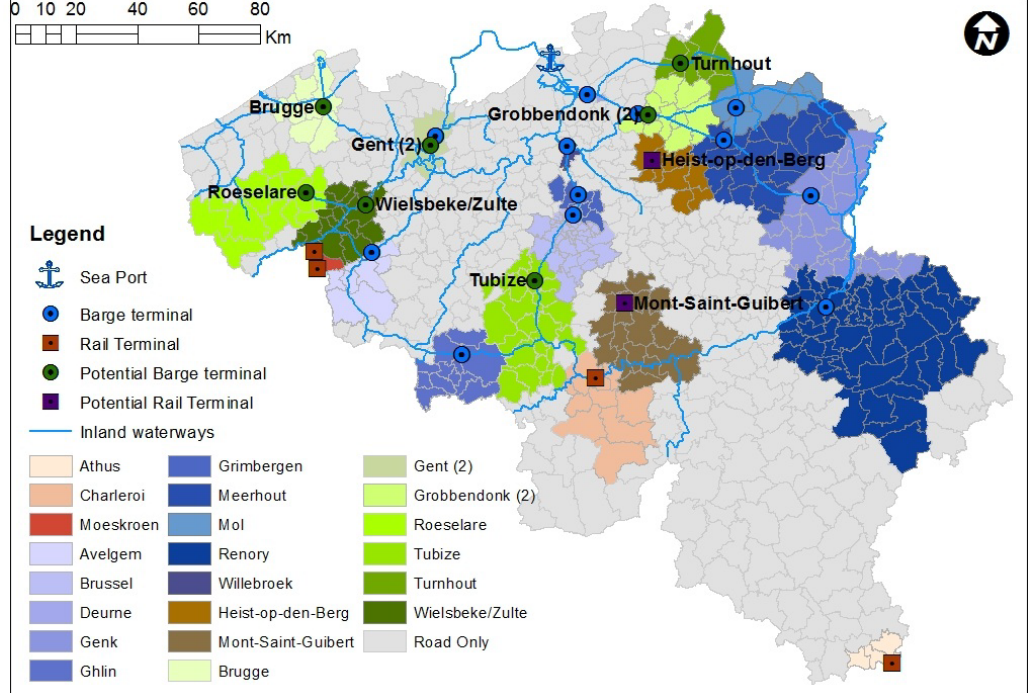
Figure 6. Nine potential terminal locations in Belgium with the highest potential transhipment volumes and their respective market areas, added to the existing terminal network.